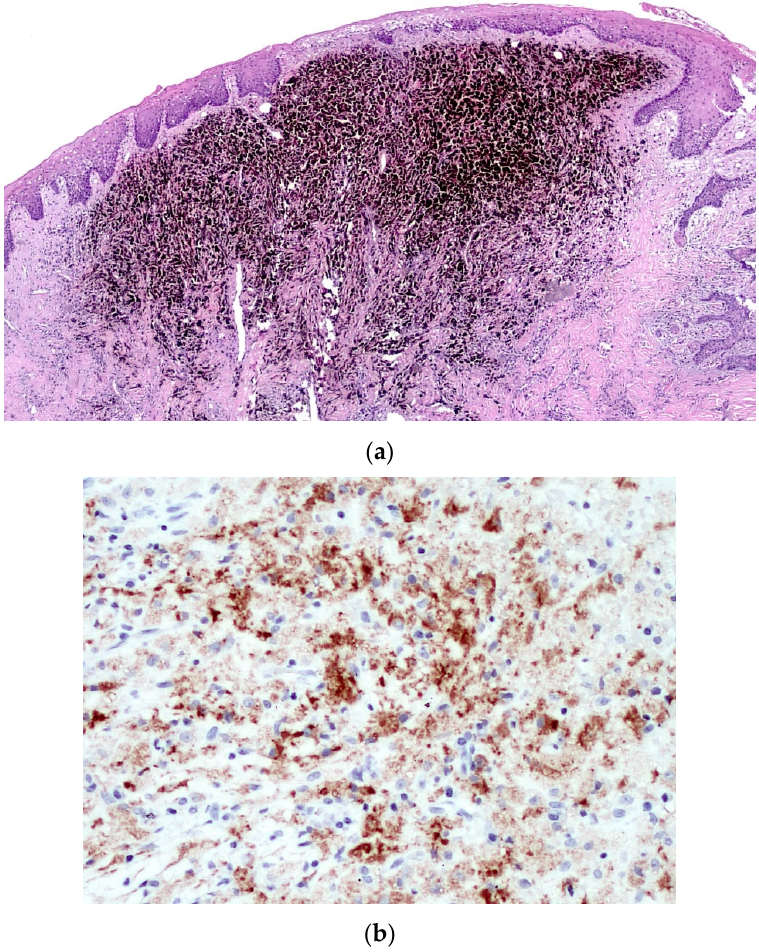
Figure 7. In this lesion, still located in the upper lamina propria, the tumor cells are filled with melanin pigment ( a ) (Hematoxylin & Eosin, × 2), and show consistent HMB-45 immunoreactivity ( b ) ( ×